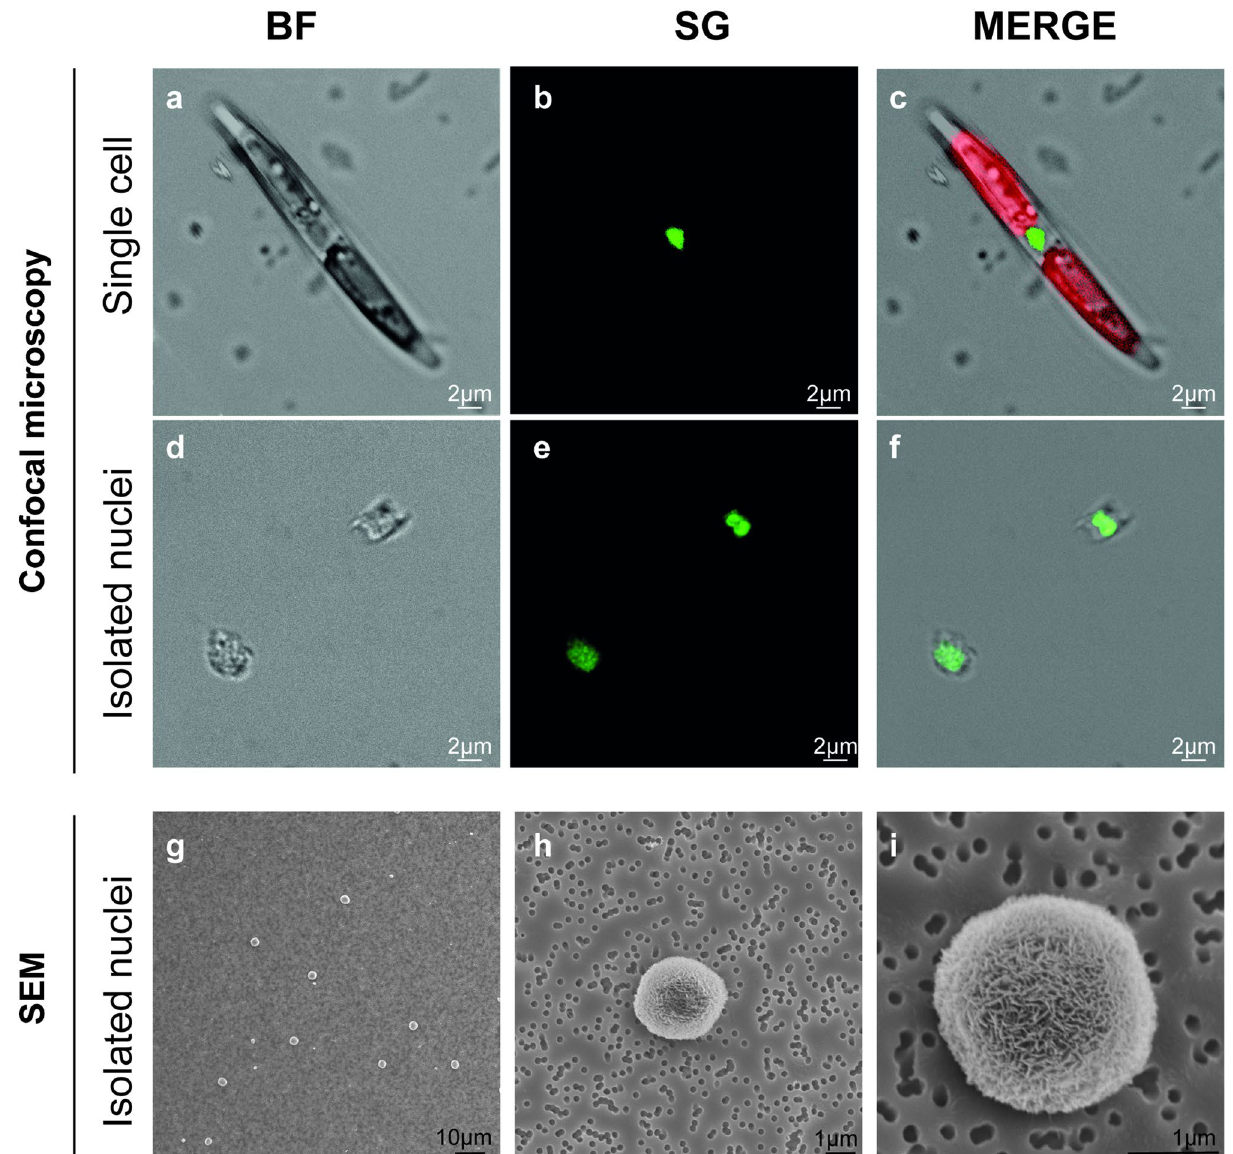
Figure 2. Microscopy analysis of P. multistriata cell and isolated nuclei. Confocal ( a – f ) and SEM ( g – i ) images of P. multistriata isolated cell ( a – c ) and nuclei ( d – i ) after the FAC-sorting procedure. In C chlorophyll autofluorescence is visible in red. BF (bright field), SG (SYBR Green